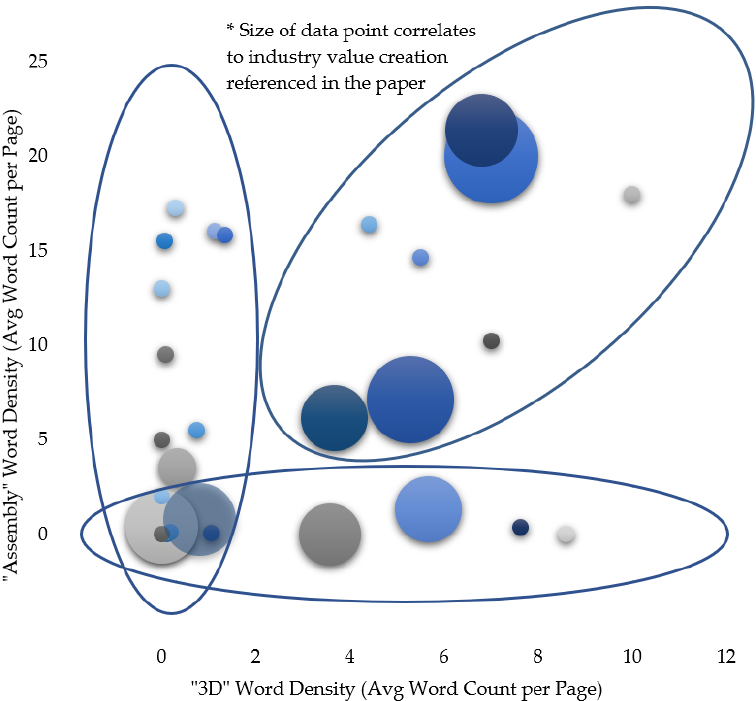
Figure 4. The 3D product model in the assembly process: literature review.